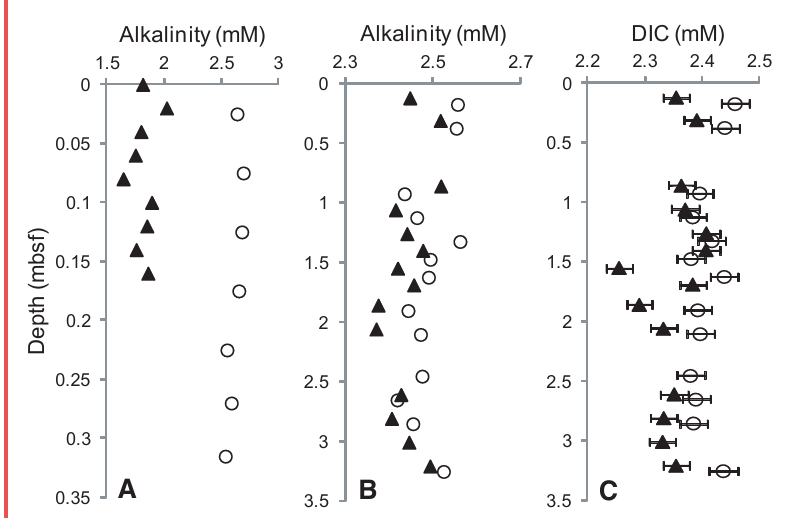
Figure 1. Alkalinity profiles at [A] SPG-9 and [B] EQP-9, and [C] DIC profile from EQP-9. Data from squeezing (open circles) and Rhizons (black triangles). Note differences in scales between sites. 0.5% error bars on alkalinity profiles are smaller than symbols. 1% error bars on